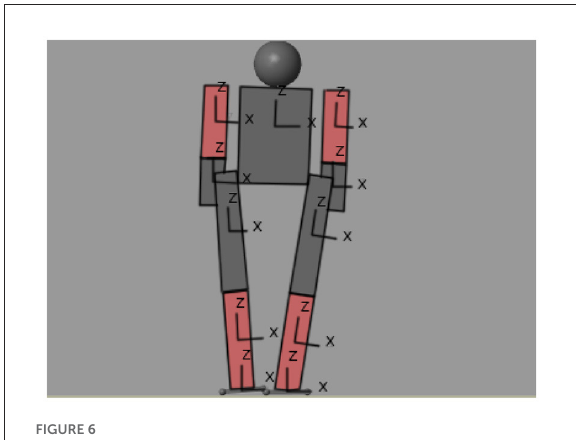
FIGURE6 First stable position of the humanoid.